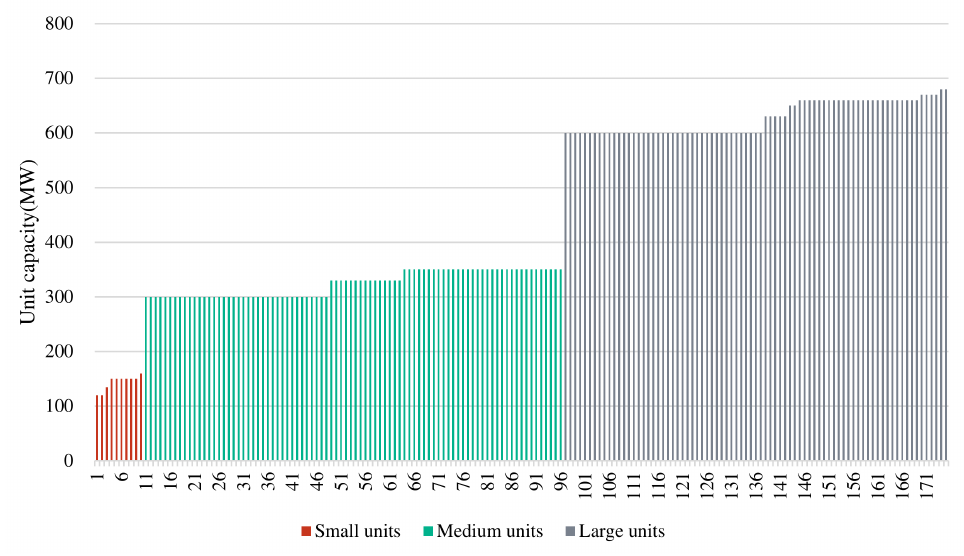
Figure A2. Classification of coal power generating units in coastal cities in